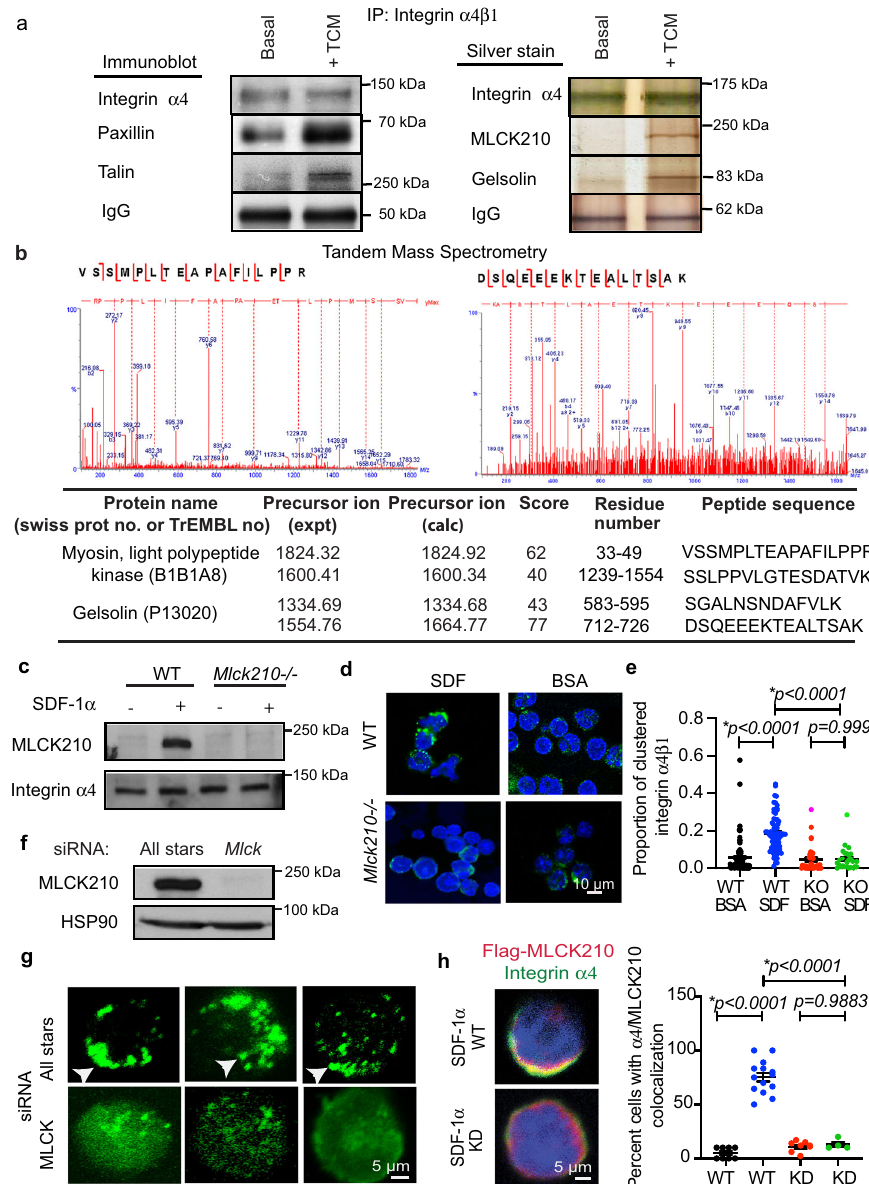
To determine whether MLCK210 and integrin α 4 β 1 colocalize but not BSA induced colocalization of paxillin (red) and integrin α 4 (green) in Mlck210 WT but not KD transfected cells in the same membrane domains upon chemokine stimulation, we transiently transfected Mlck210 − / − cells with Flag-tagged wild- (Supplementary Fig. 2d, e). Taken together, these results type and kinase-dead MLCK210. Because antibodies directed demonstrate that MLCK210 closely associates with integrin α 4 against MLCK react with multiple MLCK isoforms, selective in the plasma membrane and is required to promote integrin α 4 β 1 clustering in response to chemokine stimulation. detection of MLCK210 by immuno fl uorescence in intact cells could only be accomplished by transfecting Mlck210 − / − cells with these Flag-tagged constructs. Flag-tagged wildtype and kinase- dead Mlck210 transfected myeloid cells were incubated with SDF- MLCK210 is required for integrin α 4 β 1-mediated cell adhe- 1 α or BSA coated 0.9 µm microbeads, fi xed, permeabilized, and sion . Our prior studies showed that integrin α 4 β 1 mediates analyzed for colocalization of MLCK210 (red) and integrin α 4 myeloid cell adhesion to vascular cell adhesion molecule 1 (green) by immuno fl uorescence microscopy. We found that SDF- (VCAM-1) on endothelium, leading to tumor in fl ammation and 1 α but not BSA induced colocalization of MLCK210 (red) and growth 6 – 8 . We found that a wide array of chemokines and integrin α 4 (green) in Mlck210 WT but not KD transfected cells cytokines stimulated adhesion to endothelial monolayers (Fig. 1h; Supplementary Fig. 2a – c). MLCK210 and integrin α 4 (HUVEC) or VCAM-1-coated substrates of CFDA-labeled per- overlap in the merged images can be observed as regions of yellow ipheral blood CD11b + myeloid cells from WT mice but not from color indicated by arrows. Additionally, we found that SDF-1 α mice with an integrin α 4Y991 inactivating mutation (Fig. 2a). To NATURE COMMUNICATIONS| (2022) 13:1768